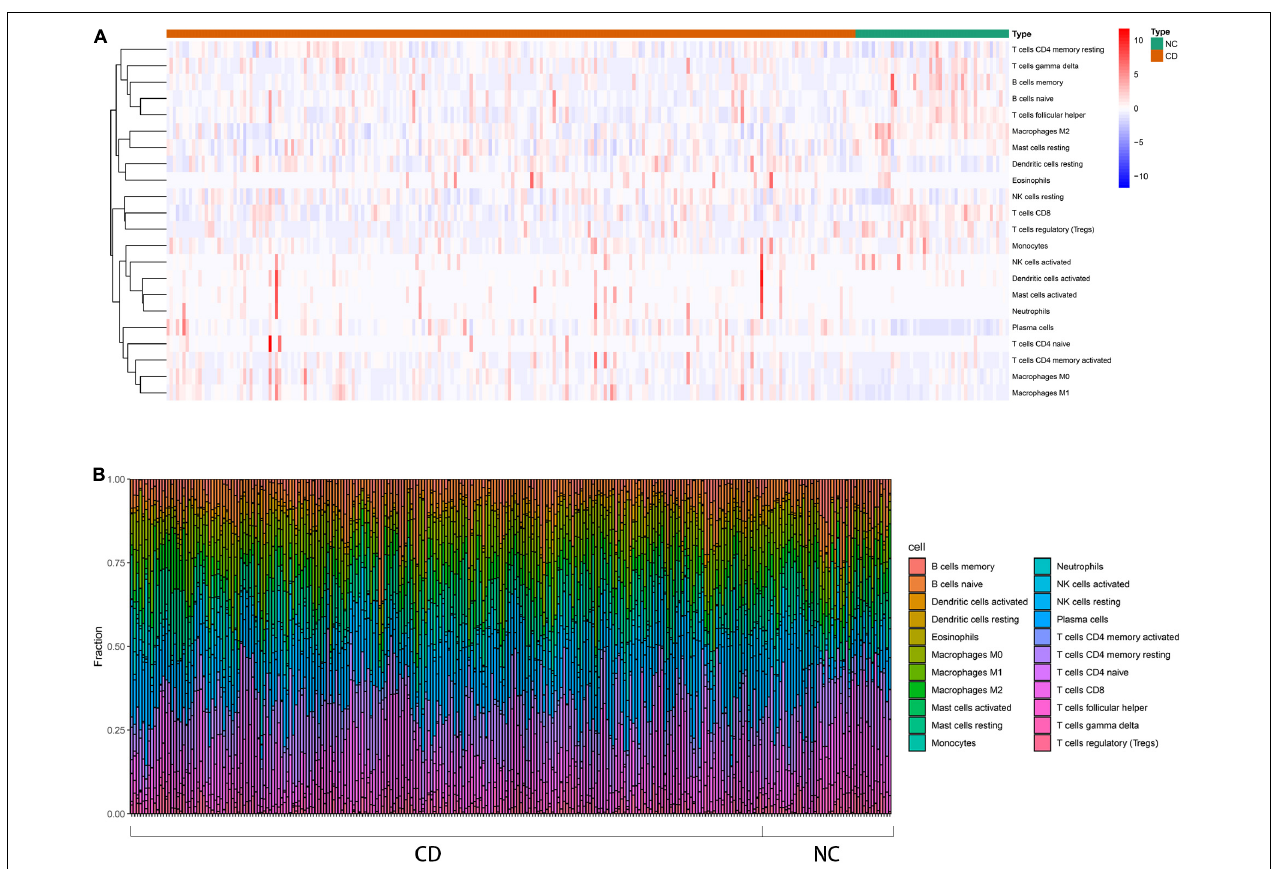
FIGURE 3 | Distribution of immune cells between CD patients and healthy controls using CIBERSORTx for all eligible samples in the derivation cohort. (A) Heatmap of the normalized absolute abundance for each cell type in individual samples. (B) Barplot of different the fractions of immune cells in individual